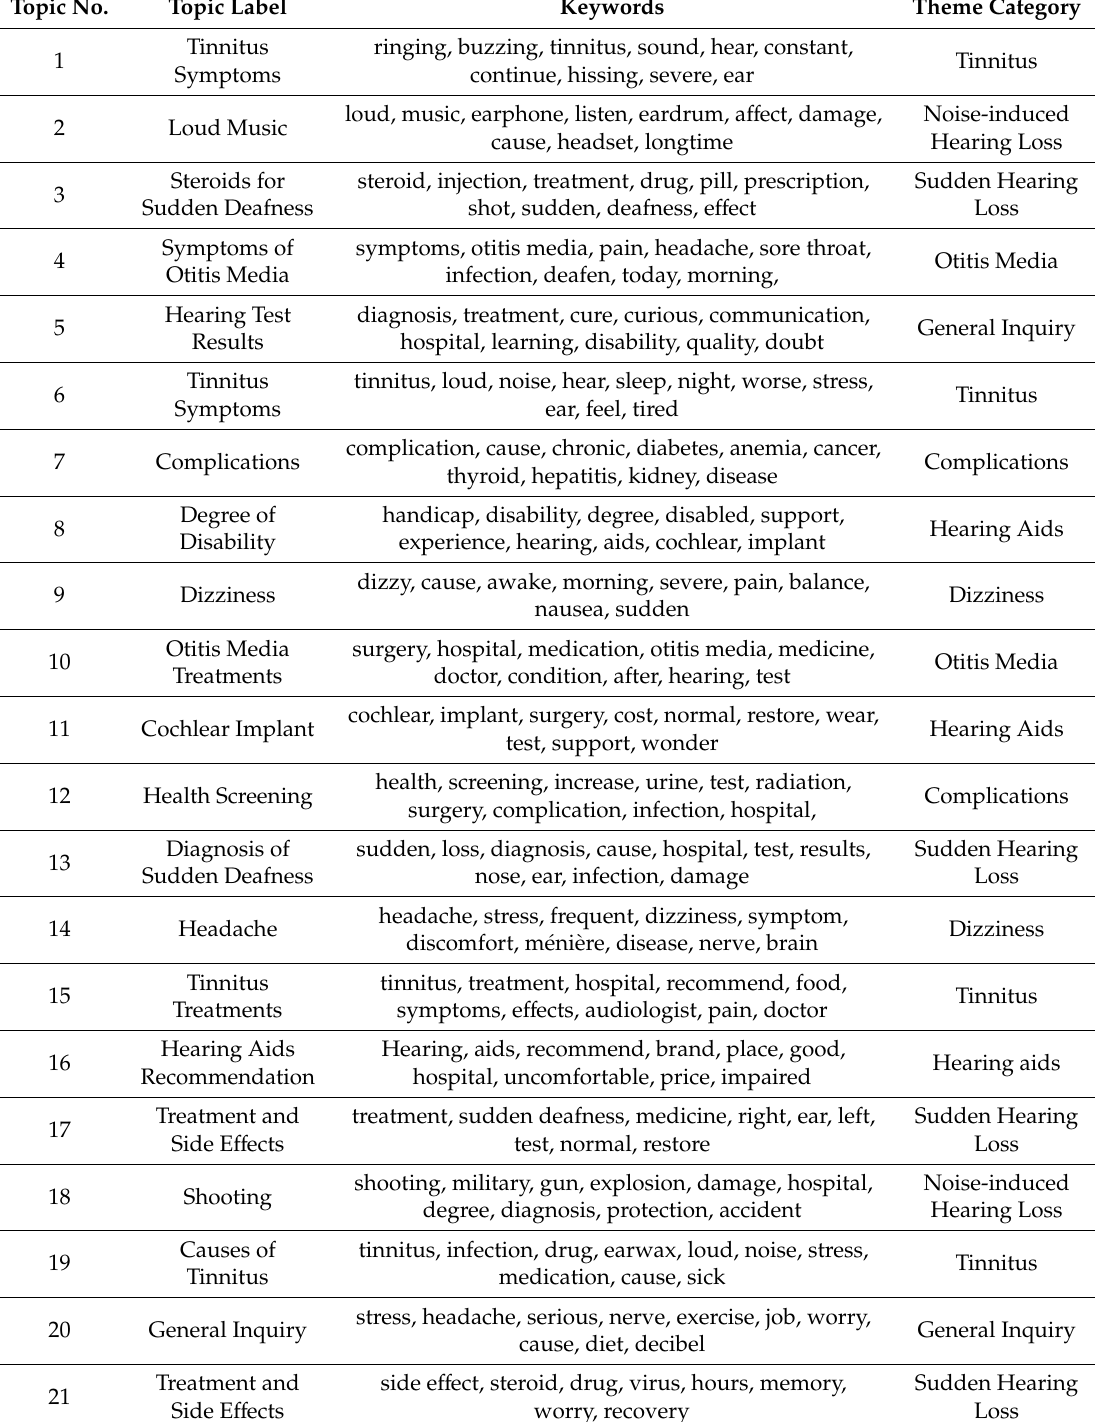
Table 1. The most probable keywords in the topic of LDA with 21 topics. Topic